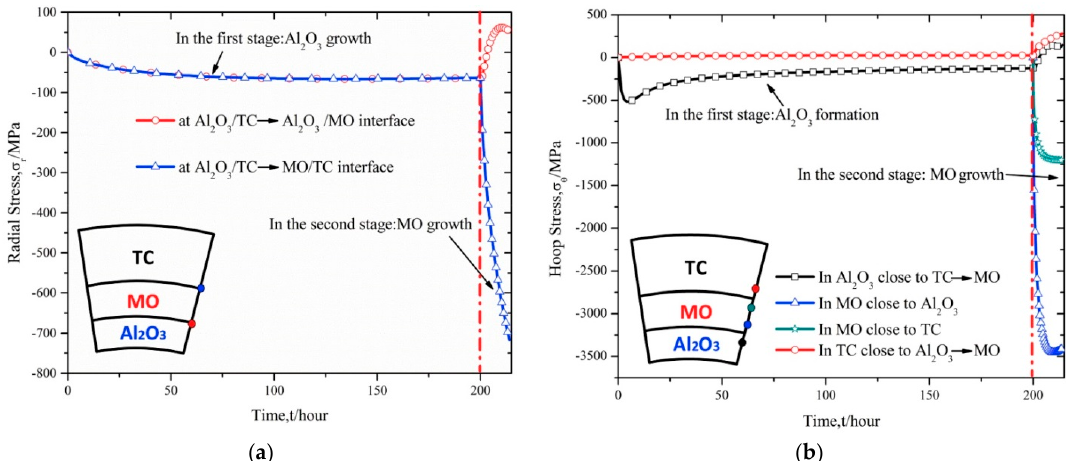
Figure 8. The stress evolution at the typical locations during the α -Al 2 O 3 and MO growth stages; ( a ) radial stress; ( b ) hoop stress [11].